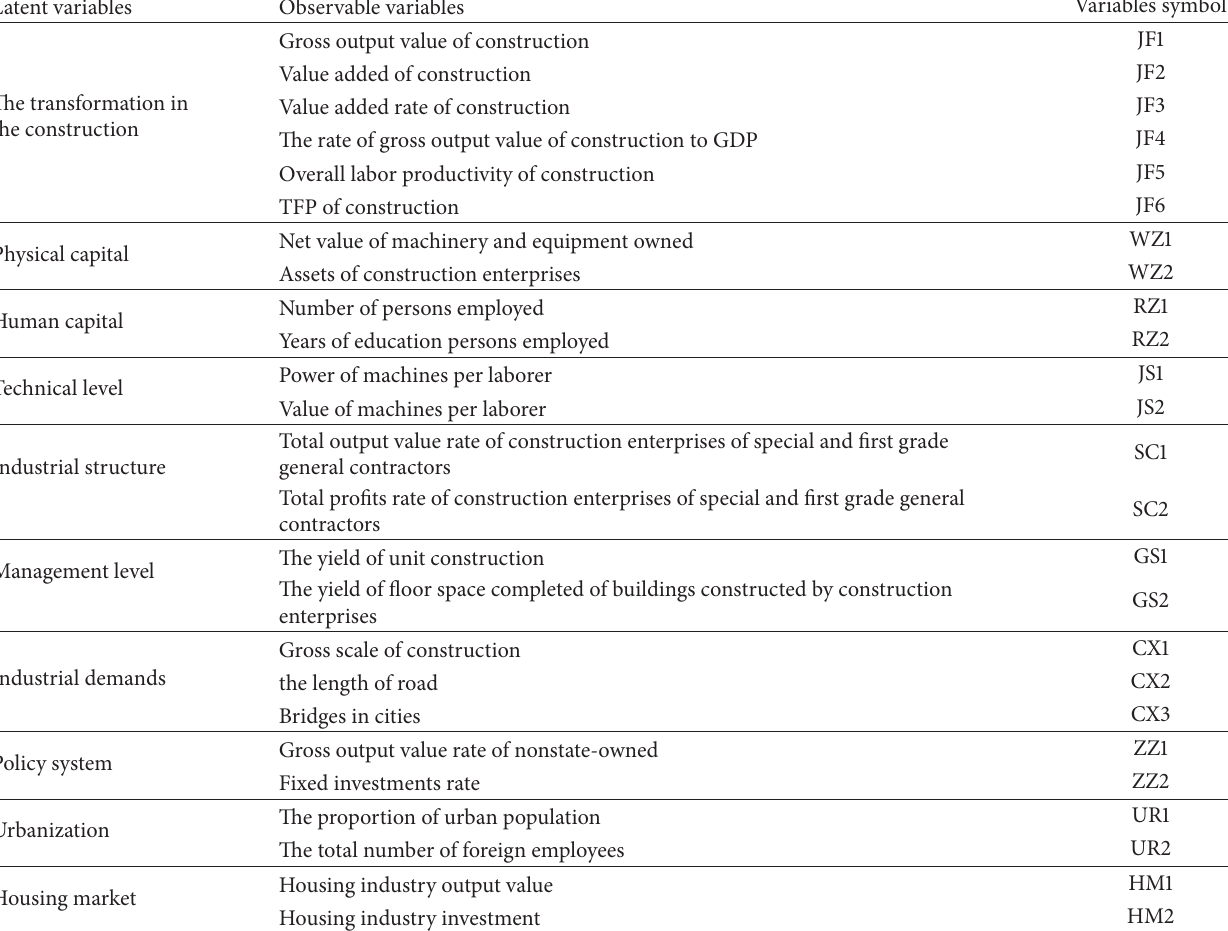
Table 1: The factors influencing indicators analysis of economic development transformation.